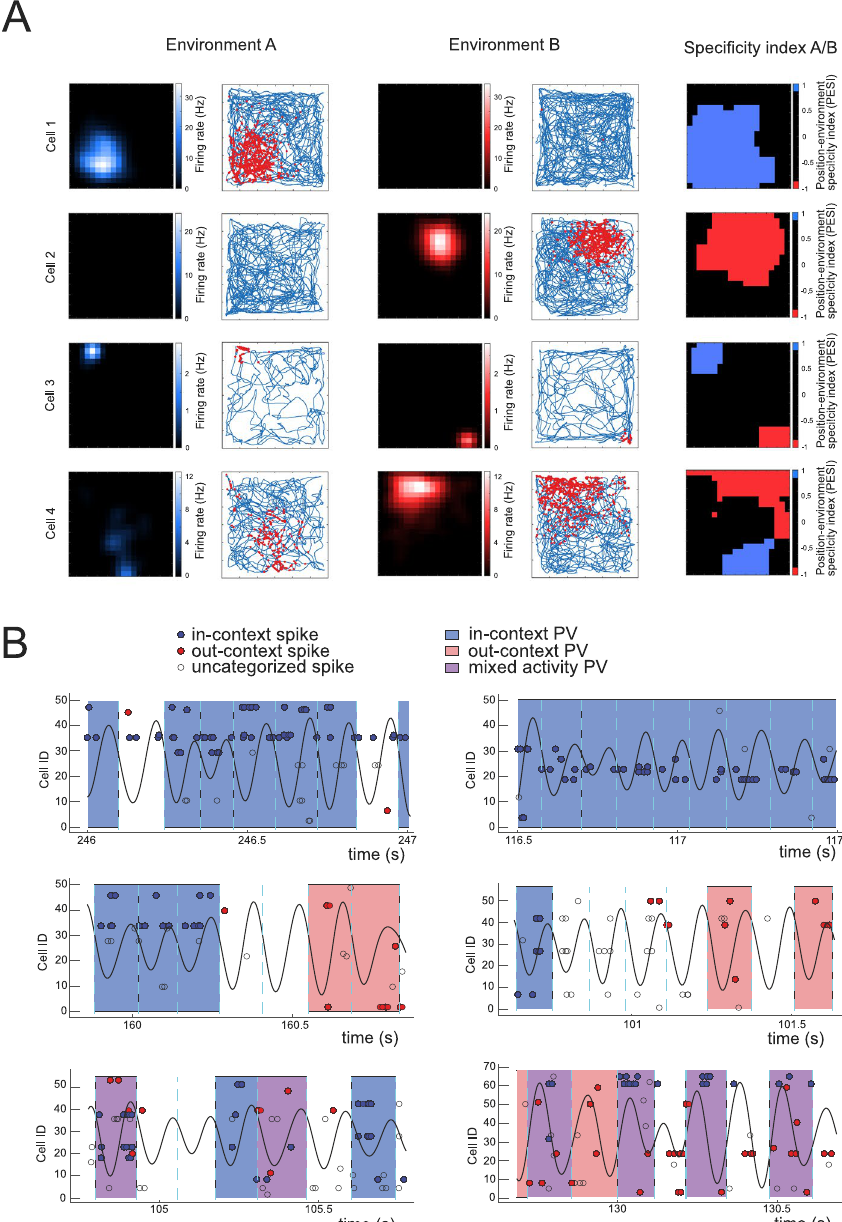
Figure 2. Examples of cell and population activity. ( A ) Examples of activity from four individual CA3 cells across environments A and B. The first four columns represent ratemaps and a track (blue line) with superposed spikes (red dots) from template sessions in environments A and B. The column on the right displays the position bins where the cell demonstrated the activity specific to one of the environments, either A (blue) or B (red). Some cells (# 3 and 4) were active in both environments. Only the cell´s activity in bins with the absolute specificity index was considered in later analysis. ( B ) Examples of population activity categorization. Population activity patterns categorized as in-context (ICPV) are colored with blue, the out-context (OCPV) with red, and the mixed patterns (MPV) with purple. The criteria are described in the Methods section. The black bold curve represents filtered LFP (8–12 Hz) and the dashed cyan lines show identified borders between the population vector bins. Spikes (circles) from individual cells (in lines) are marked with red or blue if they fired at the position with an absolute specificity coding, measured by the cell´s environment specificity index. The spikes that were expected to fire according to the pre-defined template in the environment present at the time, are highlighted in blue. The spikes that were expected to fire at the given coordinate only in the alternative environment are highlighted with red. Spikes categorized as nonspecific (empty circles) appeared in spatial bins without the absolute specificity for any of the environments and were disregarded from the PV